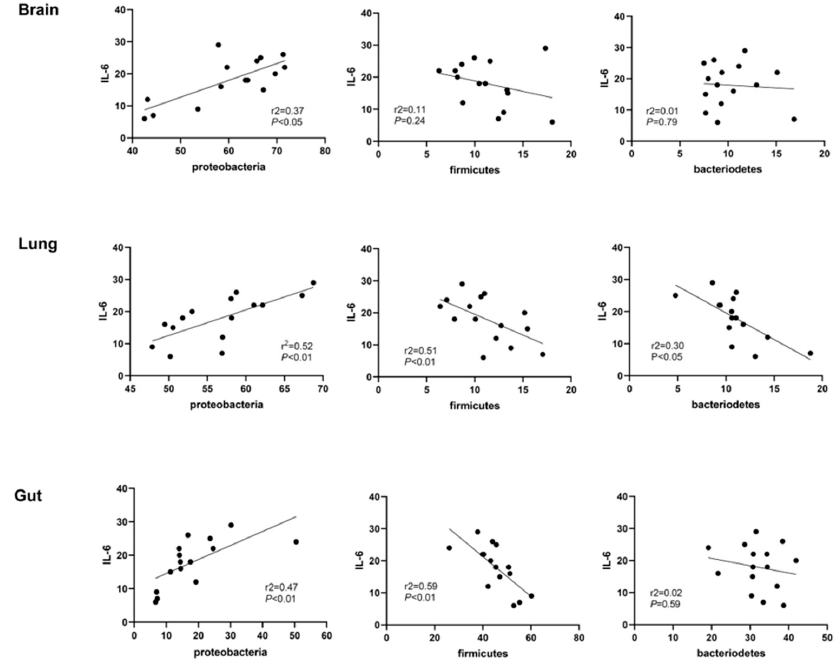
Figure 4. Association between the abundance of microbiome and IL ‐ 6 expression in the lungs. Cor